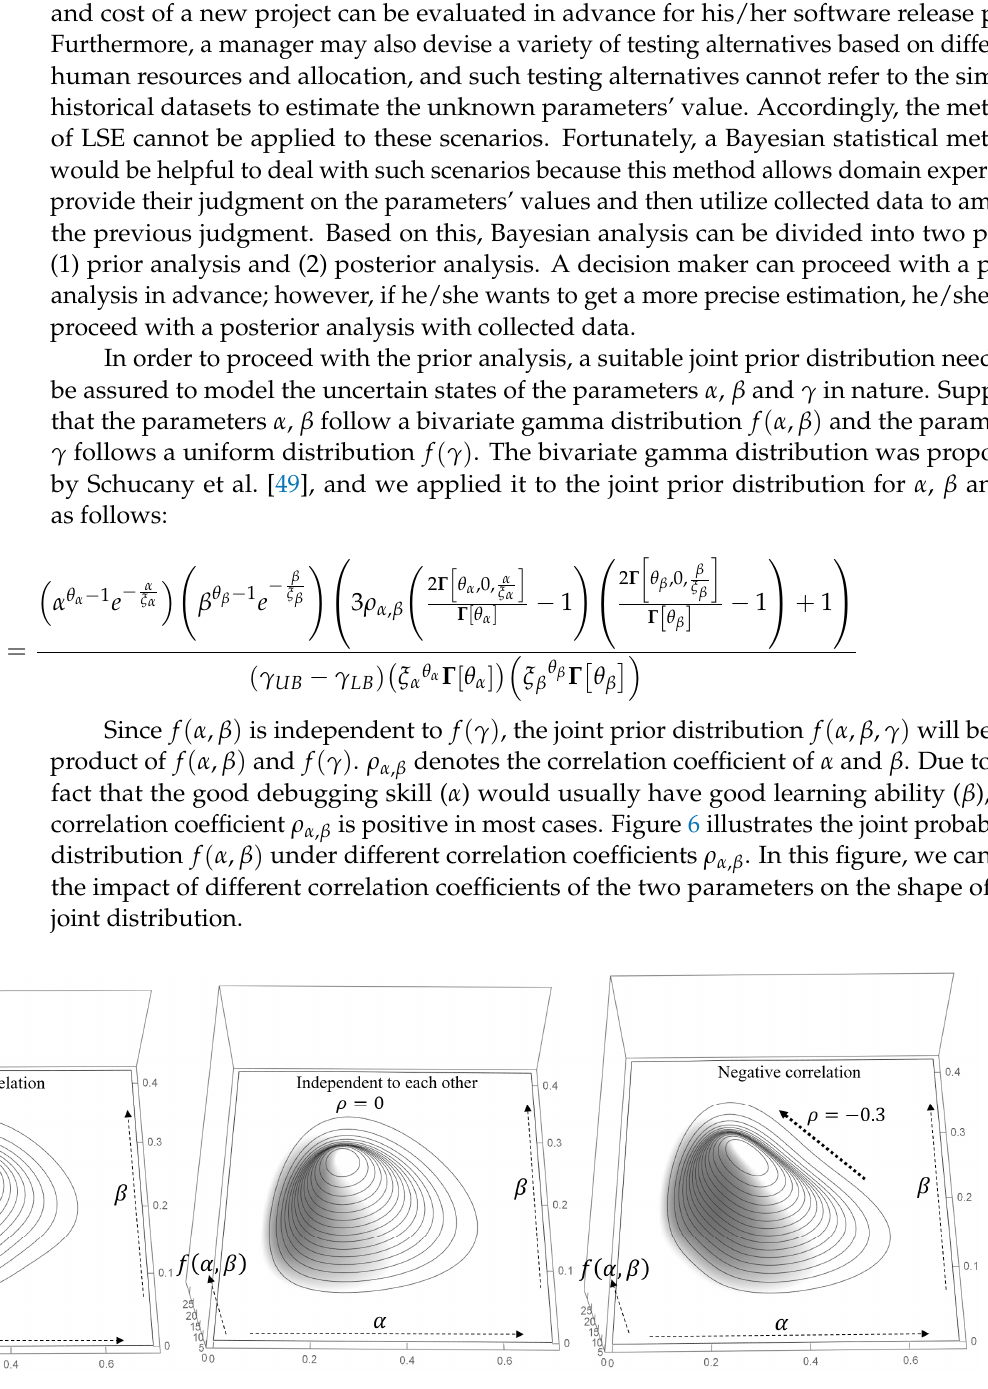
Figure 6. The joint probability distribution of 𝑓(𝛼, 𝛽) .